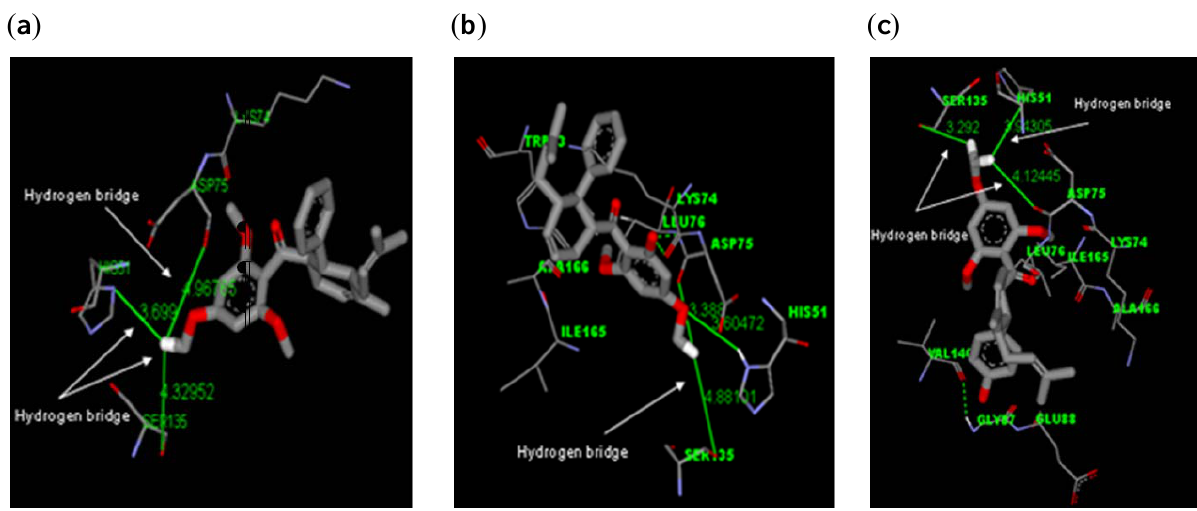
Table 4. Complexation energies and K